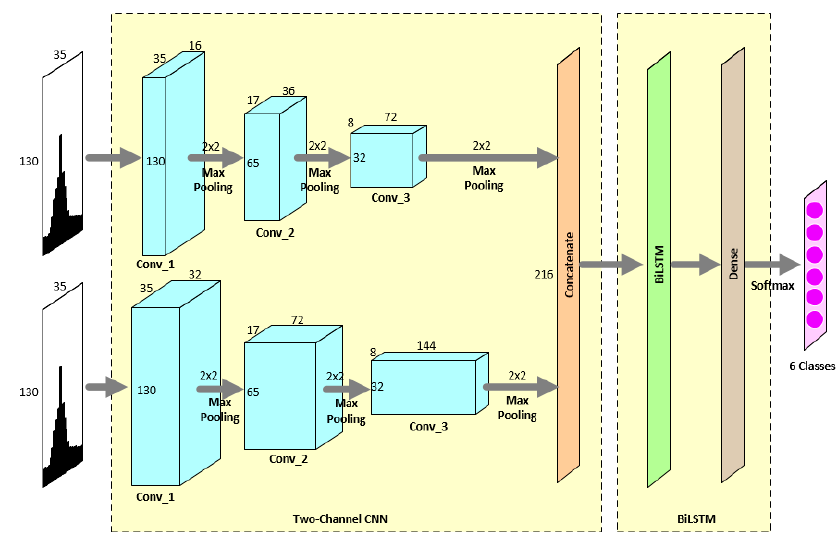
Figure 6. Proposed two-channel CNN–BiLSTM model.